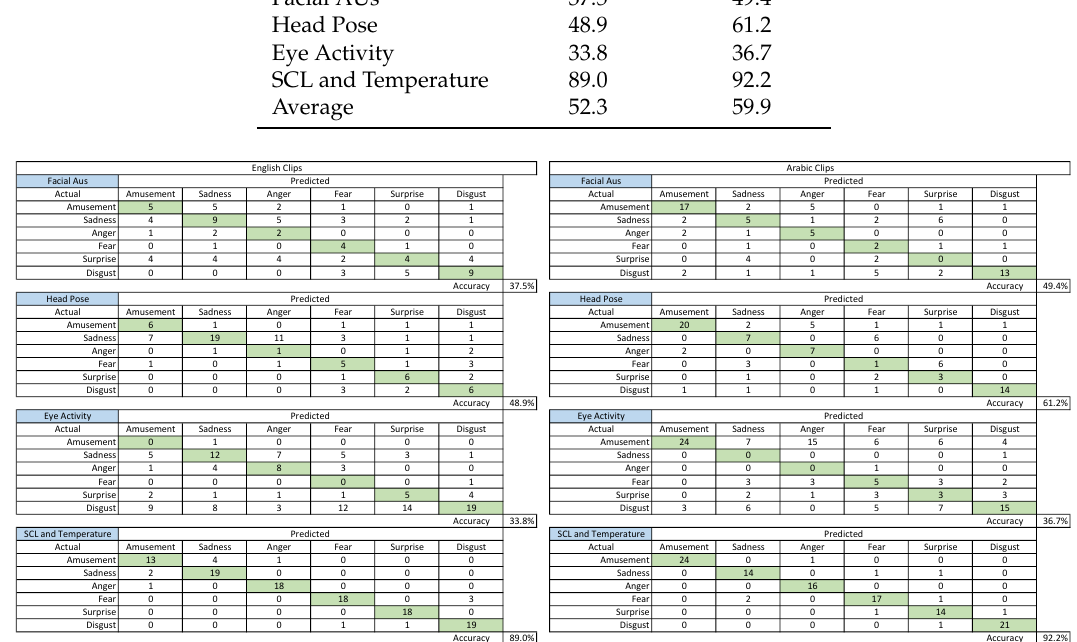
Figure 9. Confusion matrices for emotion classification from different